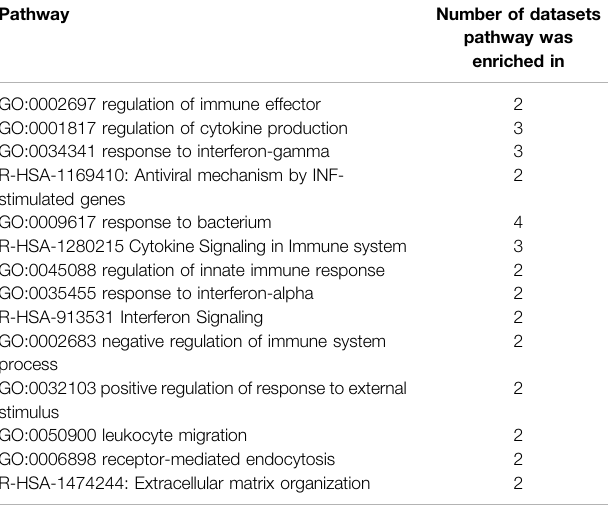
TABLE 10 | List of pathways common between multiple datasets. Pathway Number of datasets